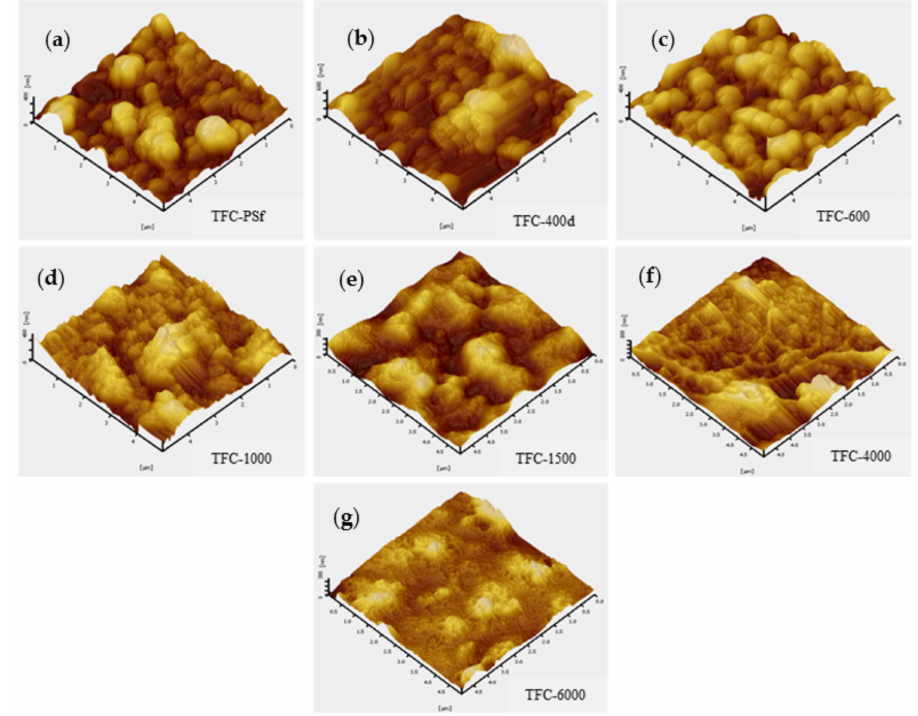
Figure 5. AFM 3D images of the pristine TFC membrane and modified TFC membranes: ( a ) TFC-PSf;